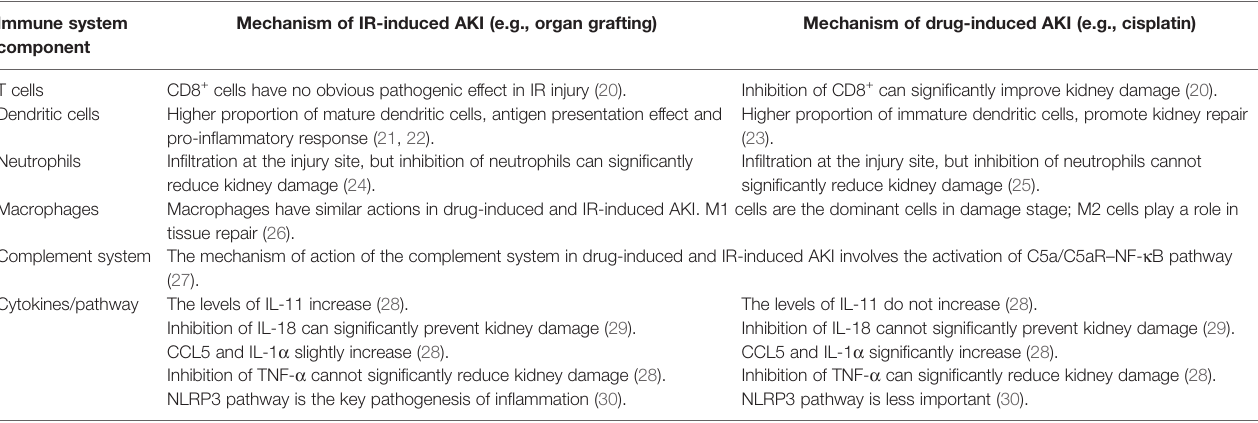
TABLE 1 | Comparison of the immune mechanisms between drug-induced and ischemia reperfusion-induced AKI. Immune system